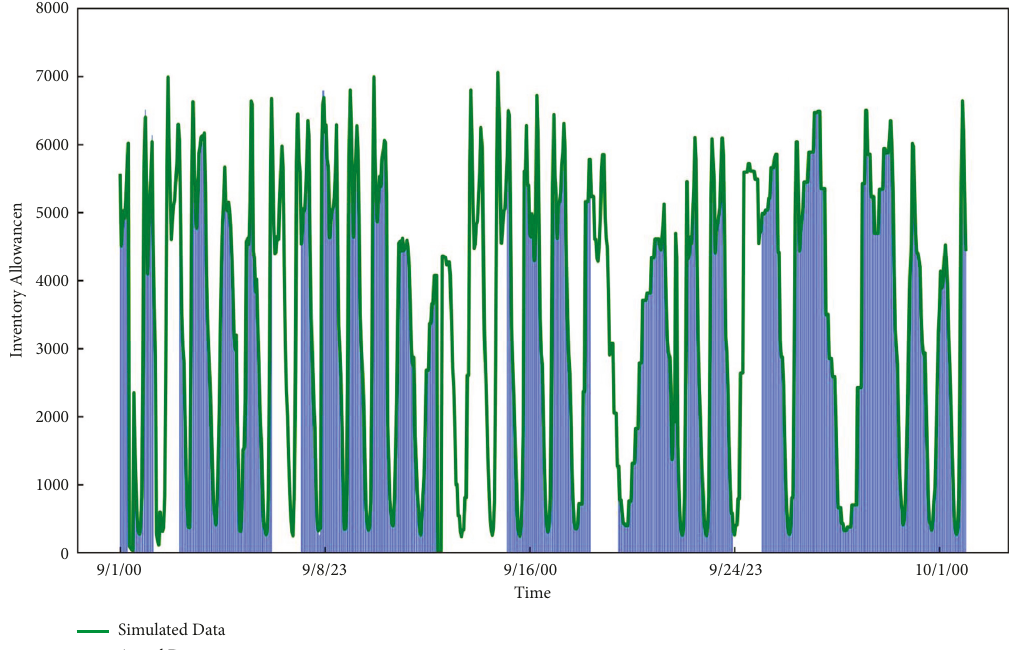
Figure 3: Improved LSTM-GL-ReMF model interpolation